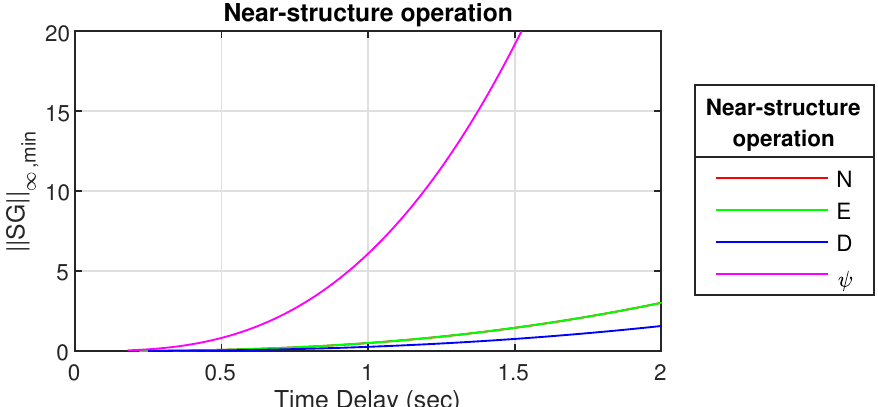
Figure 17. (cid:107) SG (cid:107) ∞ , min for near-structure operation.